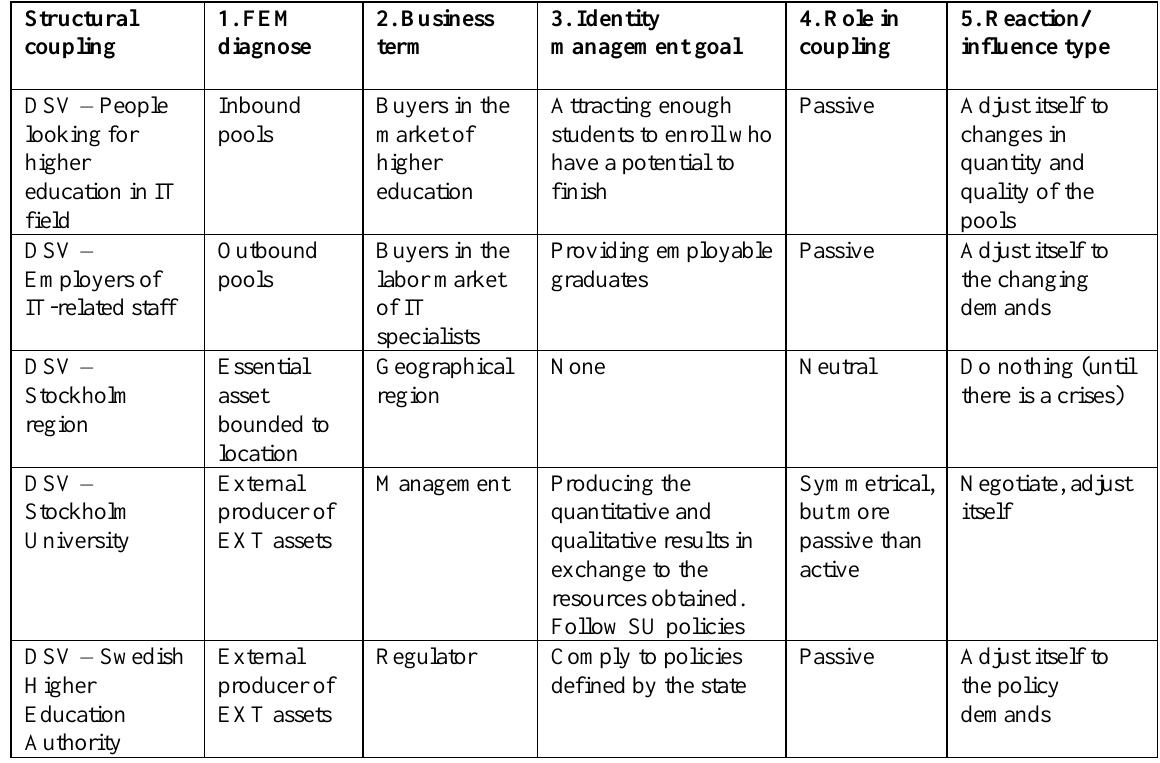
Table 2. Summary of Structural couplings of DSV